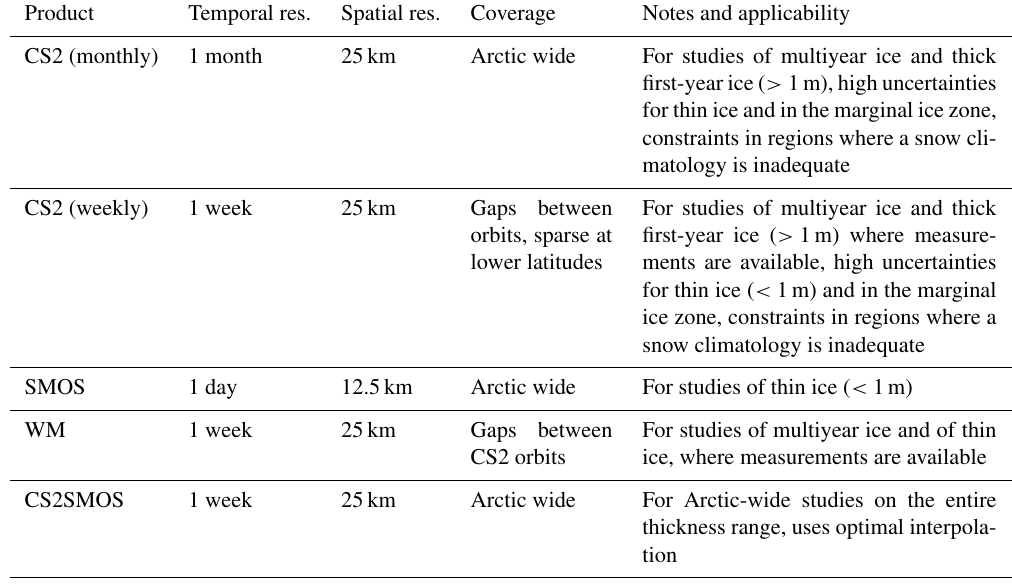
Table 1. Summary of properties of input and output sea-ice thickness products in this study, including CryoSat-2 (CS2), SMOS, the weighted mean (WM) and the OI product